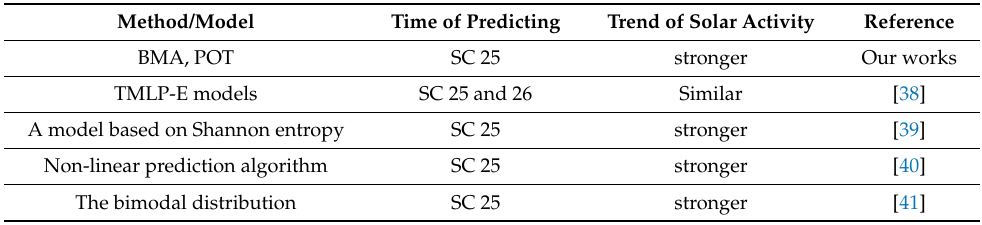
Table 5. A selection of prediction for the trend of 25th solar